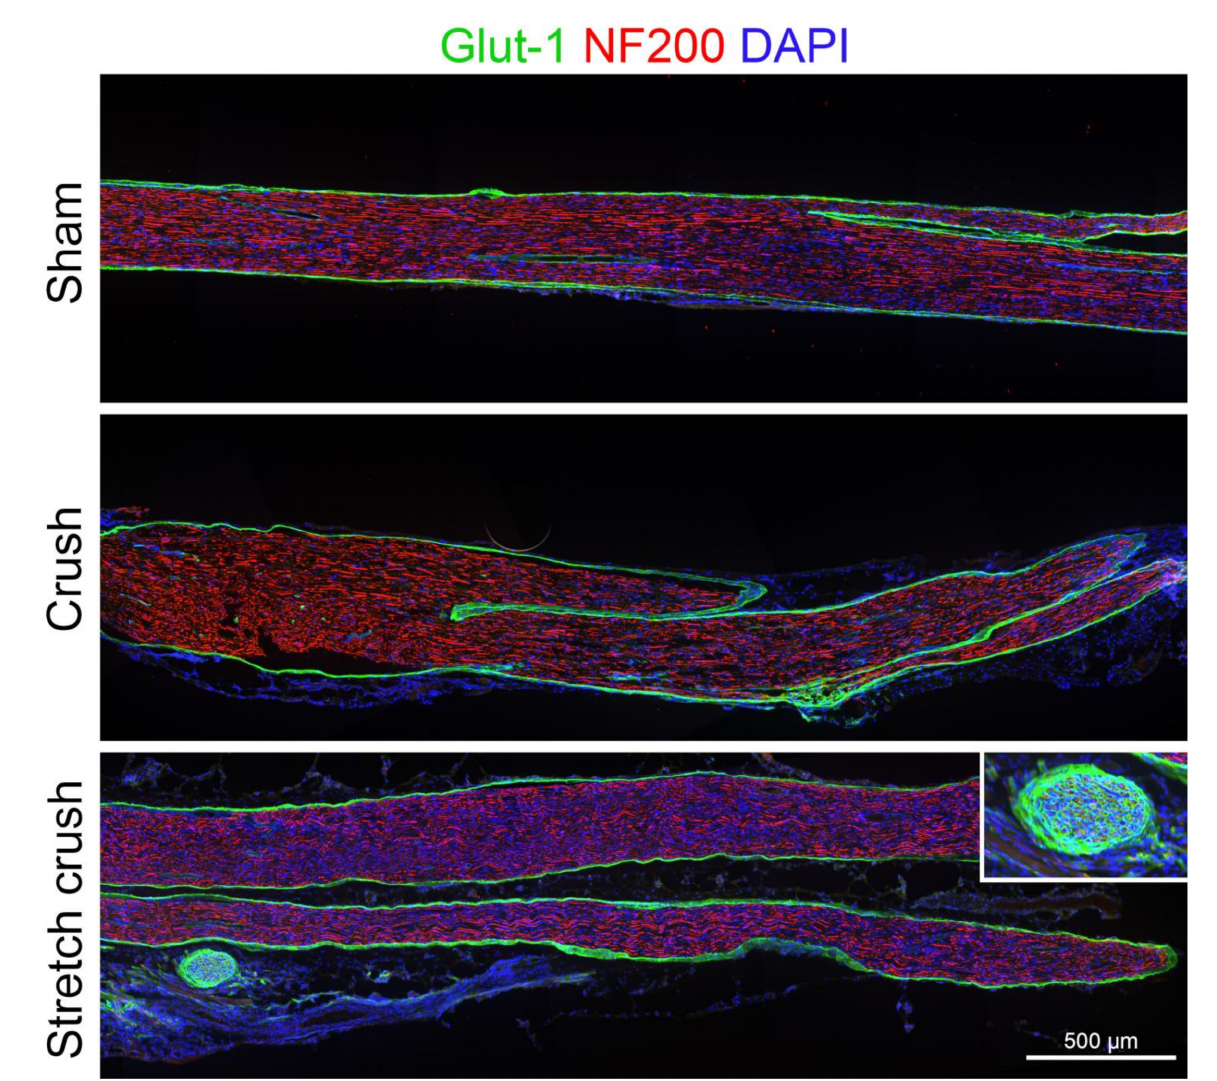
Figure 4. Six-week injury model comparison. Nerve microarchitecture is restored with intact per- ineurium in both injury types. Crush sites are not clearly identified in crush-only nerve, as markings were not clearly visible at time of sectioning. In the stretch–crush nerve, note the stained per- ineurial cells encompassing axons at injury site (insert), consistent with prior perineurium disruption (Figure 3e) and axonal regeneration intertwined with perineurial cell proliferation, findings consistent with an NIC injury. NIC, neuroma in